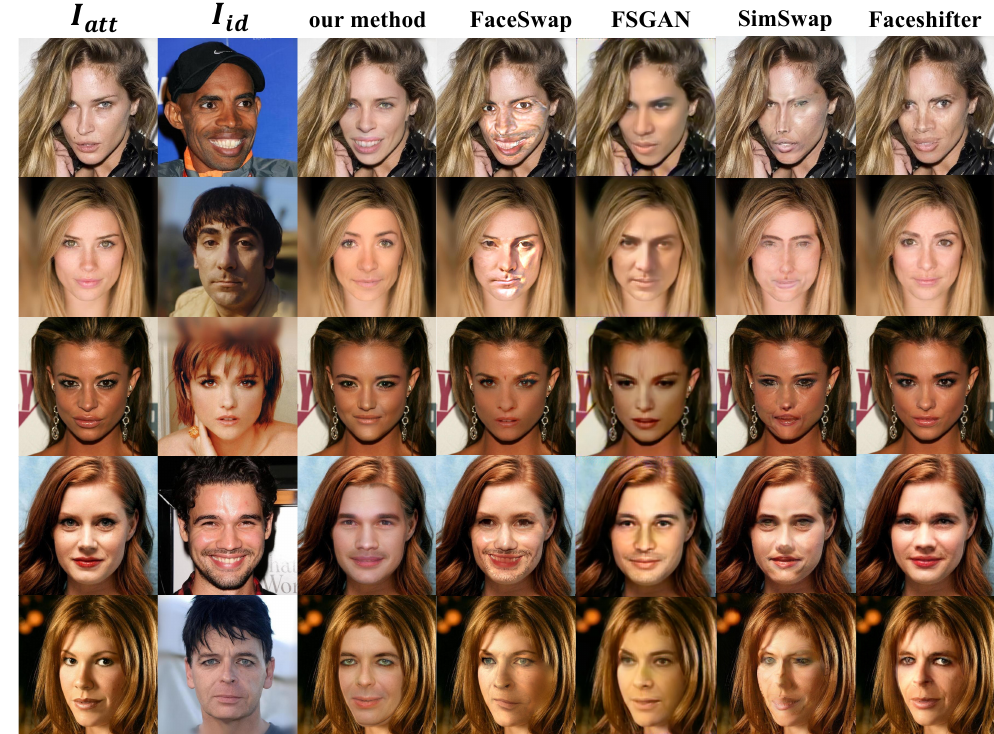
Figure 7. Compared with other methods. The comparison methods consist of FaceSwap, FSGAN, SimSwap, and Faceshifter.